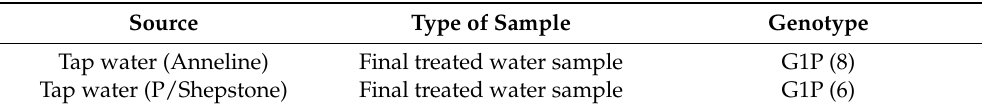
Table 5. Detection and characterisation of rotavirus from the treated drinking water collected from the urban areas (water samples n =